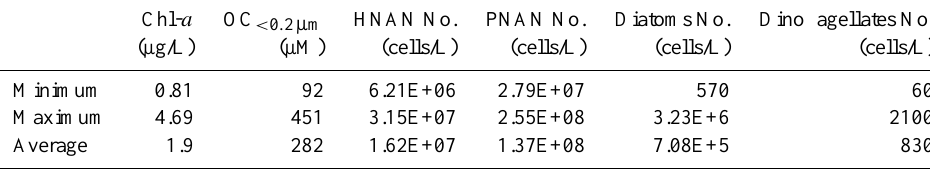
Table 1. Summary of chlorophyll- a , OC < 0 . 2 µ m concentration and cell count analysis of oceanic seawater collected during the RHaMBLe cruise in the high biological activity region near Cape Verde Islands (May–June 2007). Chl- a OC < 0 . 2 µ m HNAN No. PNAN No. Diatoms No. Dinoflagellates No. (µg/L) (µM) (cells/L) (cells/L) (cells/L) (cells/L) Minimum